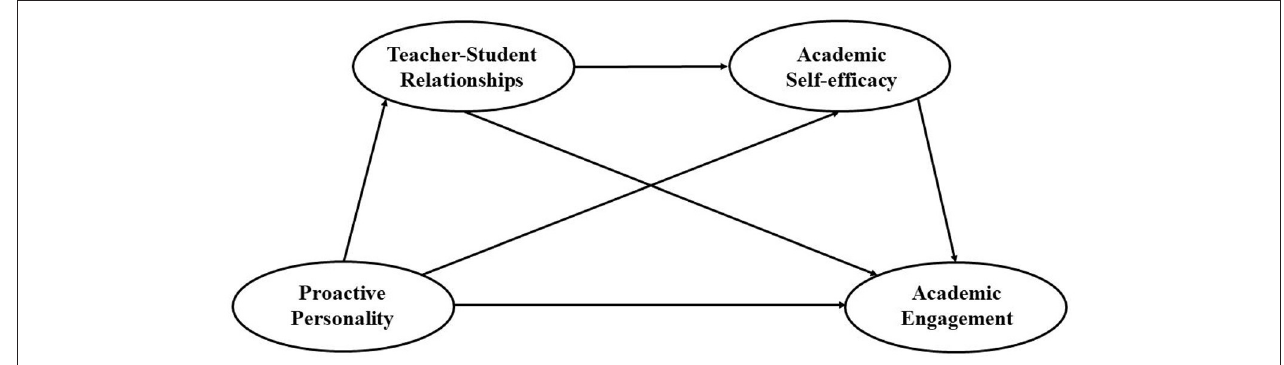
FIGURE 1 | The proposed mediation model.